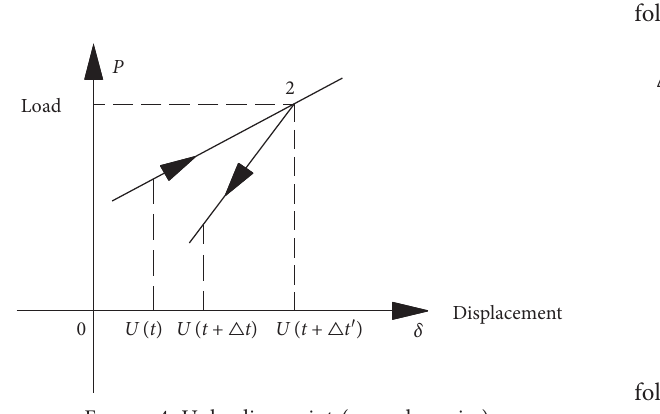
Figure 4: Unloading point (second species).